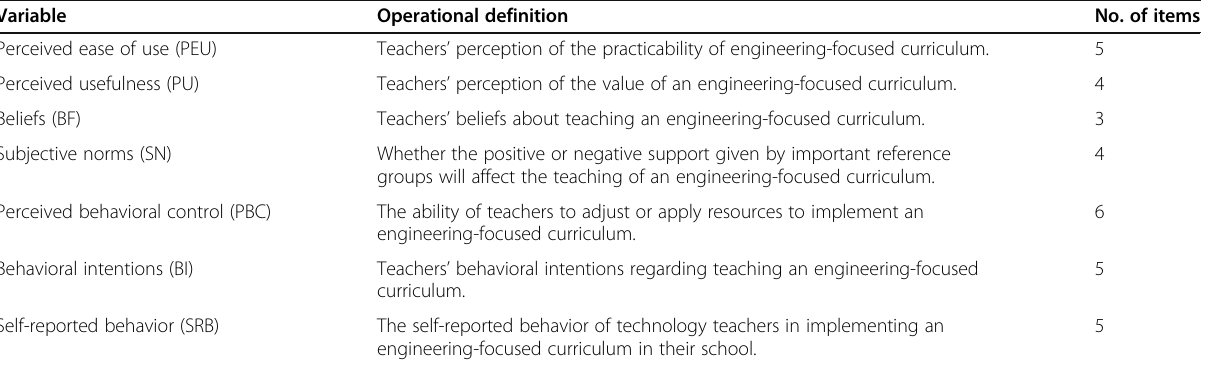
Table 1 Operational definitions of the latent variables